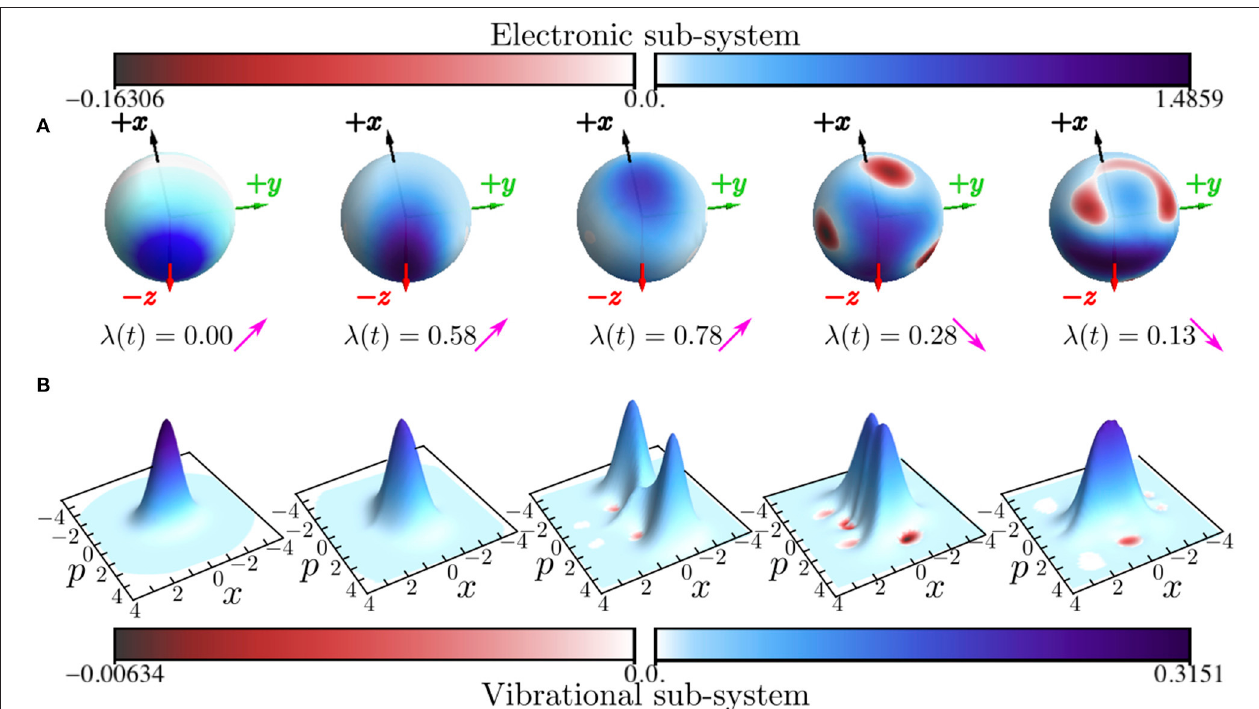
FIGURE 3 | (A) Electronic sub-system Agarwal-Wigner Functions W q and (B) boson field/vibrational sub-system Wigner functions W b , shown at two values of λ ( t ) in each portion of an up-and-down pulse cycle. The pulse cycle is depicted as the horizontal dashed line in Figure 2 for N 7. The υ value is purposely chosen not to = log 2 (υ) 5 , because we want to illustrate the type of non-classicality that can be achieved for broader be the optimal one producing the strongest coherence = − values of υ . Most importantly, by the end of just one up-and-down cycle, both W q and W b develop complex non-classical patterns for a broad range of intermediate (cid:1) (cid:0) return trip times and general N 3 (see Figure 2 ). W q and W b are phase space representations. Though positive portions may be quantum mechanical or classical, ≥ the negative portions (red and black) that appear demonstrate unambiguous non-classicality. In (A) , opposite Bloch hemispheres are not shown because of W q ( θ , φ ). In (B) , W b is represented in the x p plane of position (vertical) and momentum (horizontal) π ) symmetry: W q ( θ , φ + = −